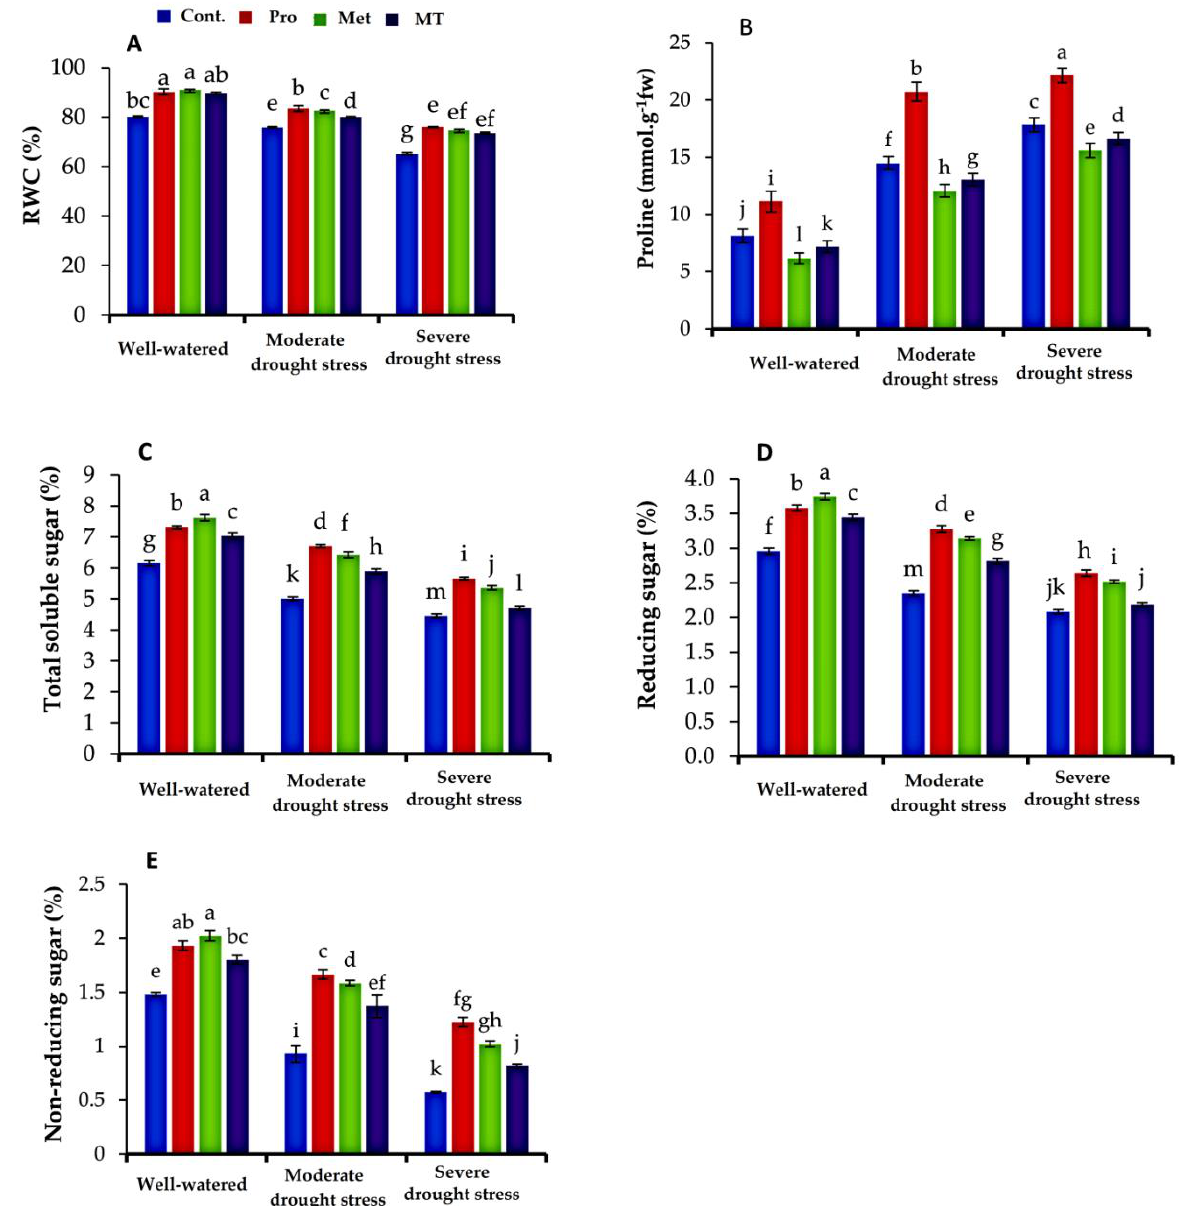
Figure 1. Impact of interaction between treatments (proline, methionine, and melatonin) and water levels on relative water content (RWC, ( A )), proline ( B ), total soluble sugar ( C ), reducing sugar ( D ), and non-reducing sugar ( E ) of cauliflower plants grown under different levels of irrigation water. Bars indicates standard error (SE) of the means (n = 6). Different letters indicate significant differences between the treatments at according to Tukey’s multiple range test ( p ≤ 0.05).